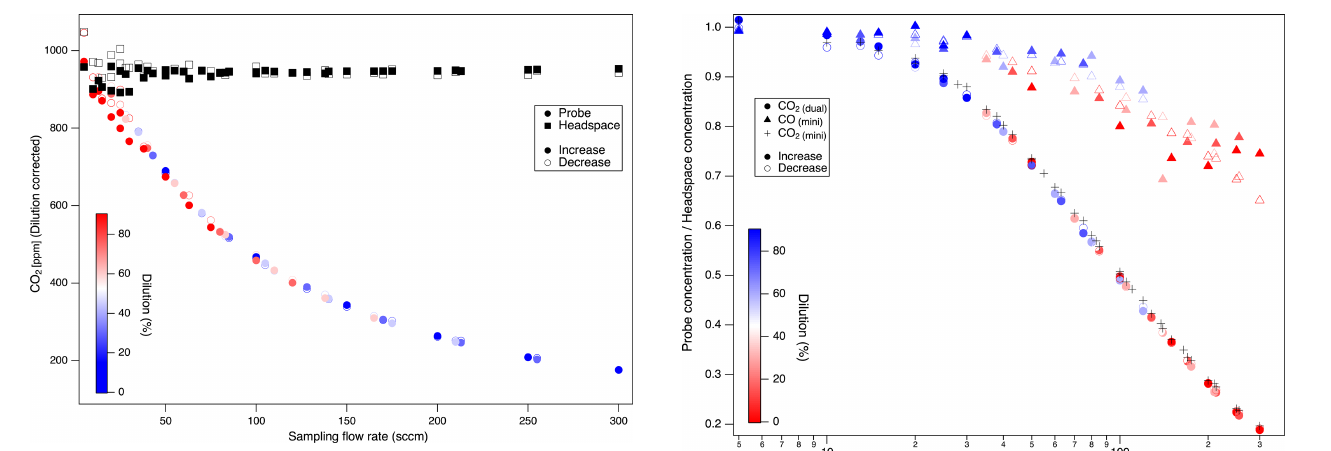
Figure 6. Probe and headspace CO 2 over a range of probe flow rates and dilution ratios (color), reflecting the recovered sample and true gas concentrations, respectively. Column soil gas concentra- tions (headspace) remained steady across the experiment, while gas concentrations sampled by the probe diverged from true values at high probe sampling flow rates. Similar patterns were observed for independent experiments run with the reverse sequence from low- to-high vs. high-to-low probe flow rates (open vs. closed symbols). CO 2 concentrations are dilution corrected (System 1 dual).